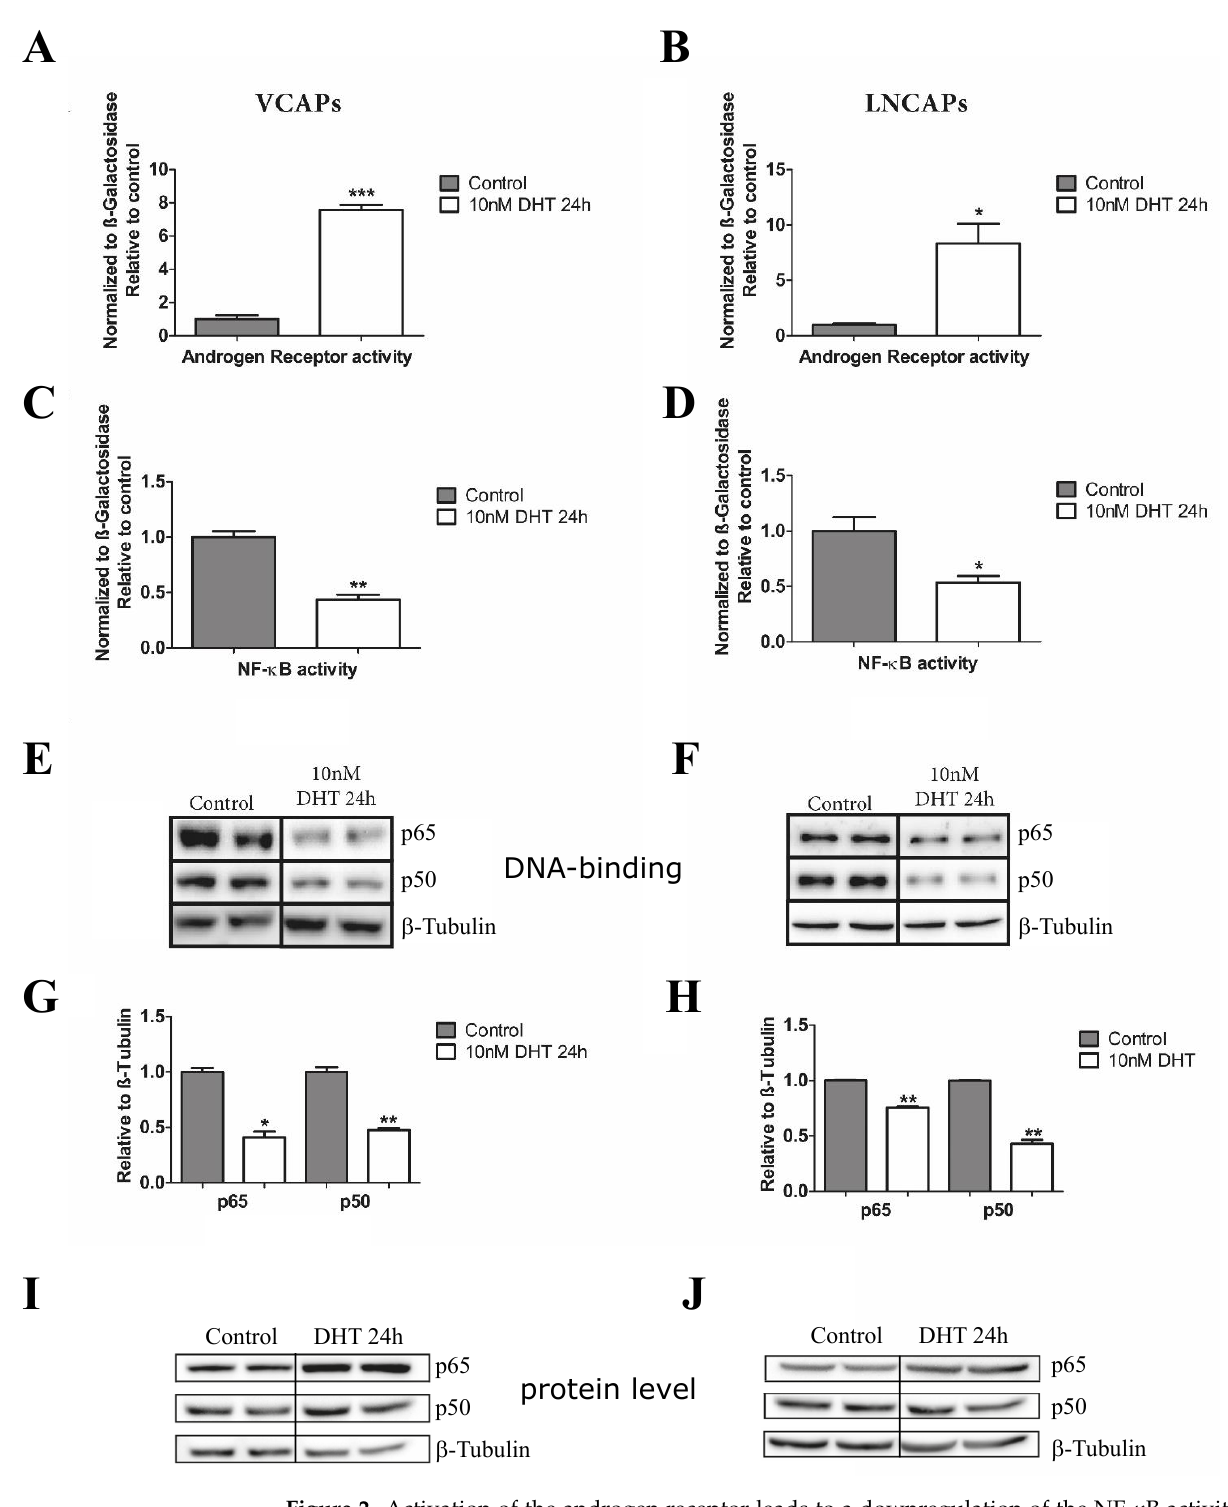
Figure 2. Activation of the androgen receptor leads to a downregulation of the NF- κ B activity in VCAP and LNCAP cells. ( A – D ) Luciferase assays for control (androgen-depleted) and DHT-treated VCAP and LNCAP cells using reporter plasmids for androgen receptor (AR) as well as NF- κ B transcriptional activity. ( E , F ) DNA binding activity of NF- κ B assessed by ABCD assays as alternative to EMSAs. β -tubulin was used as a loading control. ( G , H ) Quantification of ( E , F ). Statistical analysis was performed by two-tailed Fisher’s exact test ( n = 5; error bars represent SEM, * p < 0.05; ** p < 0.01, *** p < 0.001). ( I , J ) Protein levels of p65 and p50 NF- κ B forms of samples shown in ( E , F ). The uncropped Western blots have been shown in Figure